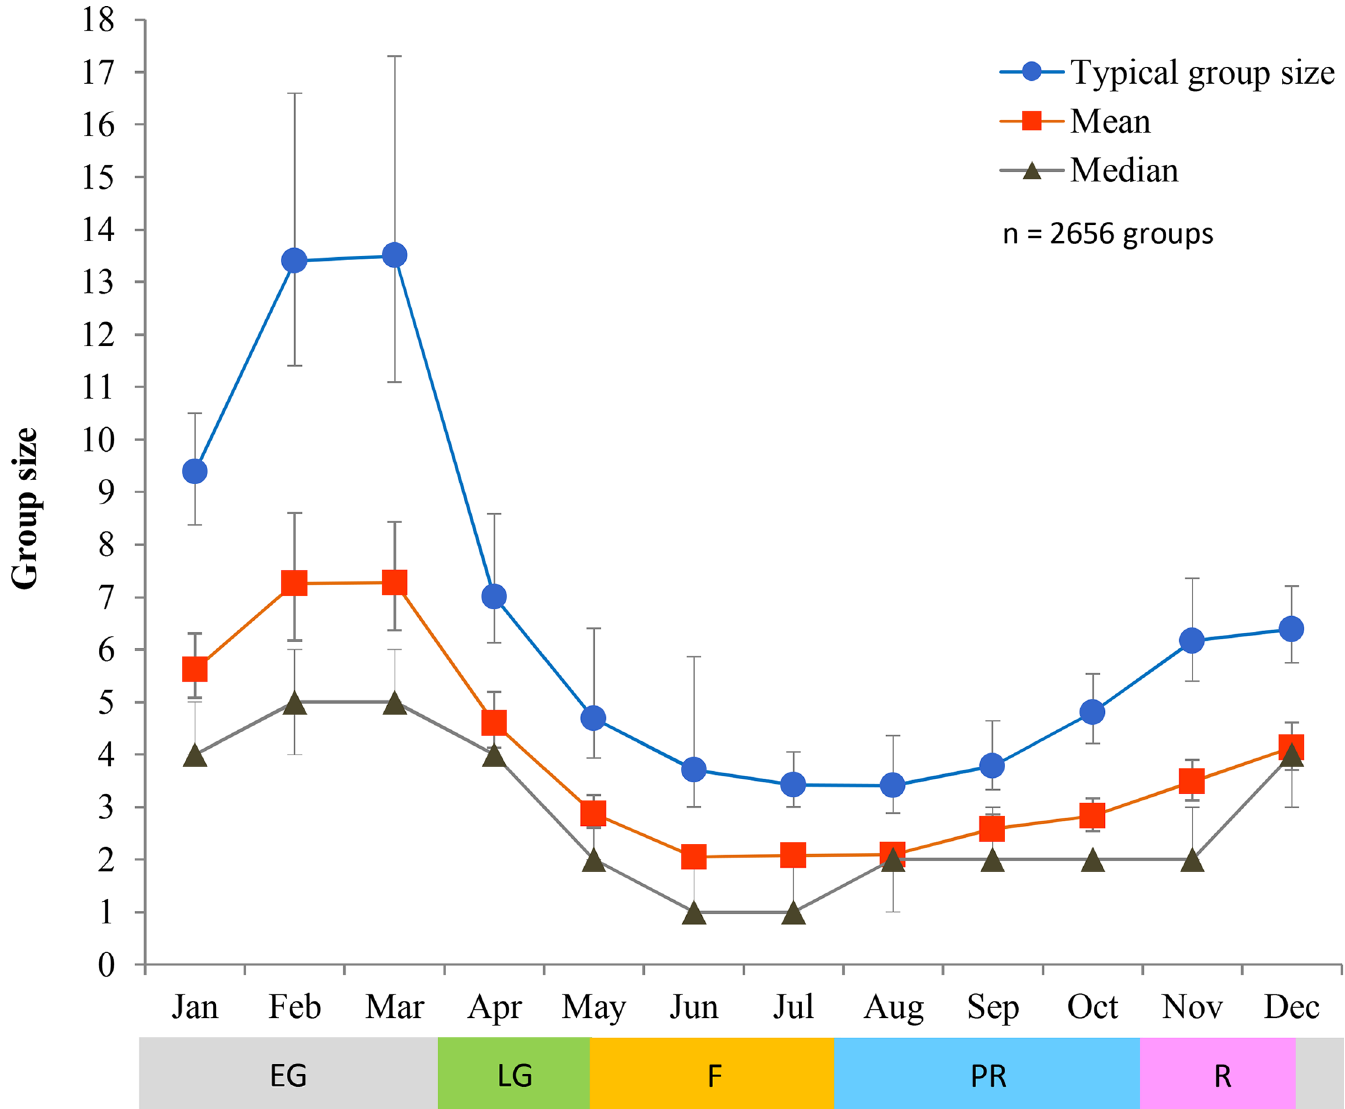
Fig 2. Monthly typical, mean and median group sizes. In typical and mean group sizes bars are 95% confidence intervals (CIs); in median group size CIs range between 95% and 96.2%. See S1 Table for actual values. EG = early gestation, LG = late gestation, F = fawning, PR = pre-rut, and R =